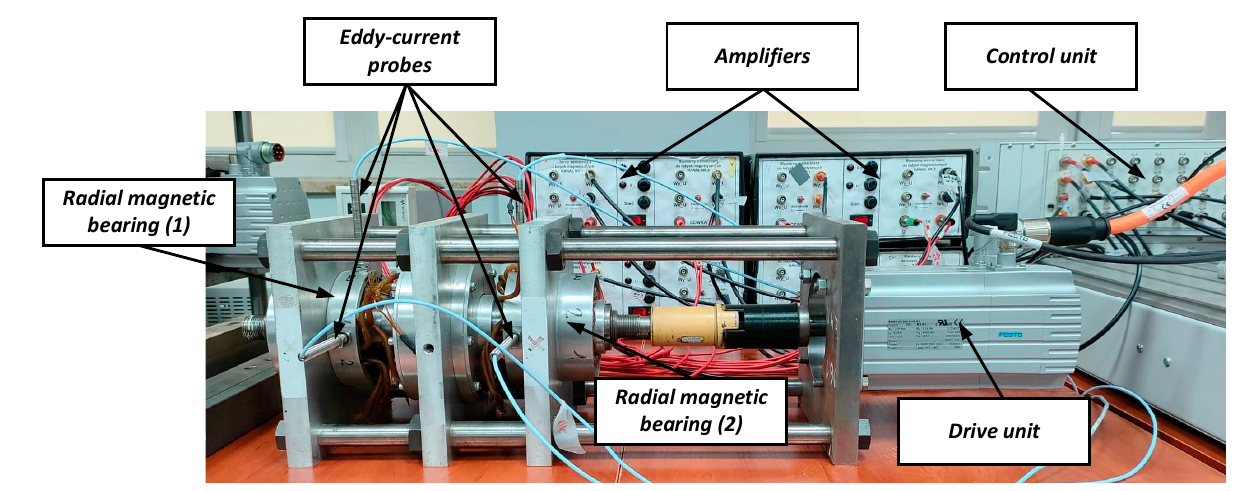
Figure 5. Test rig of magnetic support system.